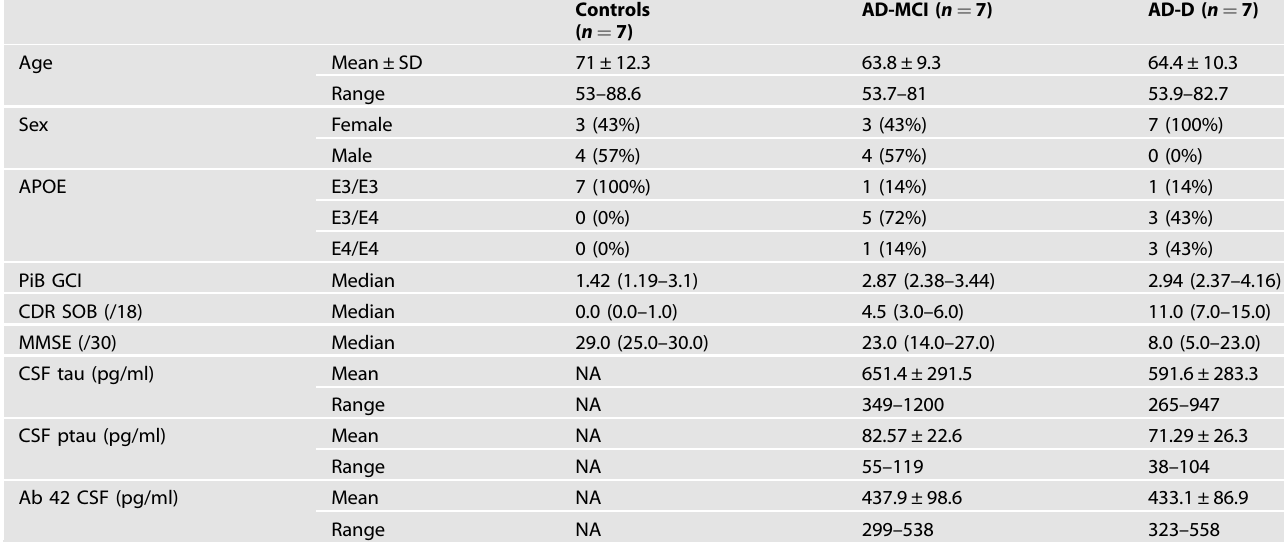
Table 1. Demographic description of the sample according to diagnostic